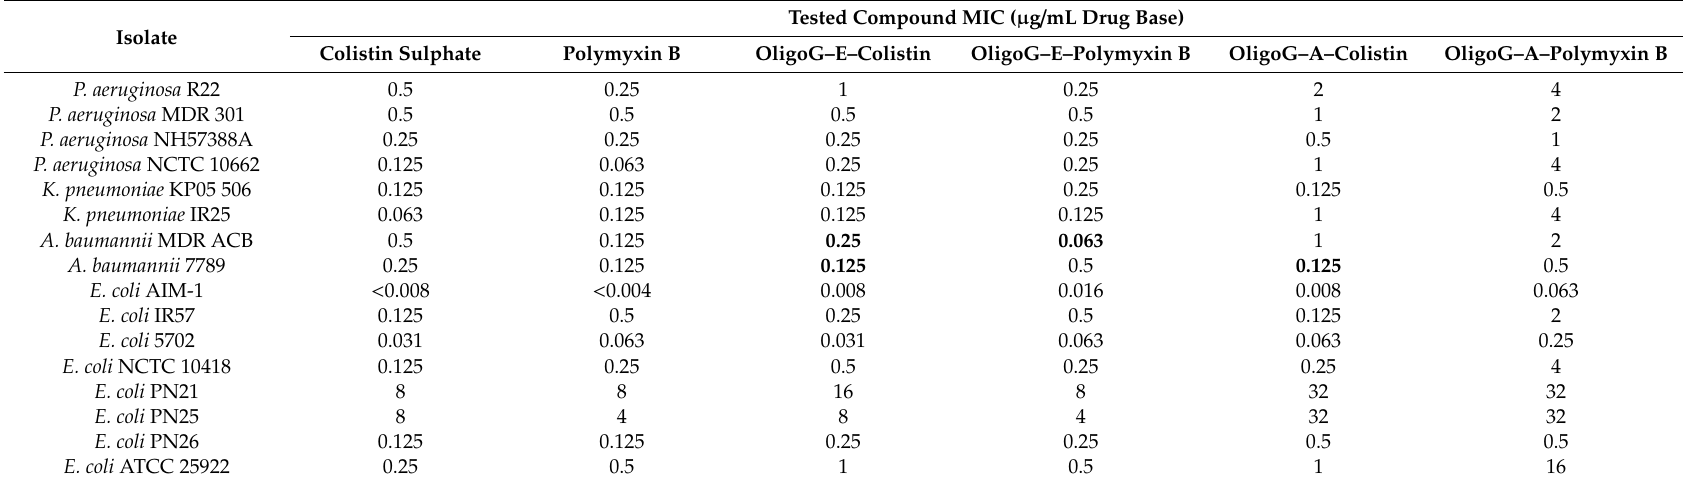
Table 2. Minimum inhibitory concentration (MIC) determinations of OligoG–polymyxin conjugates against a range of Gram-negative bacterial